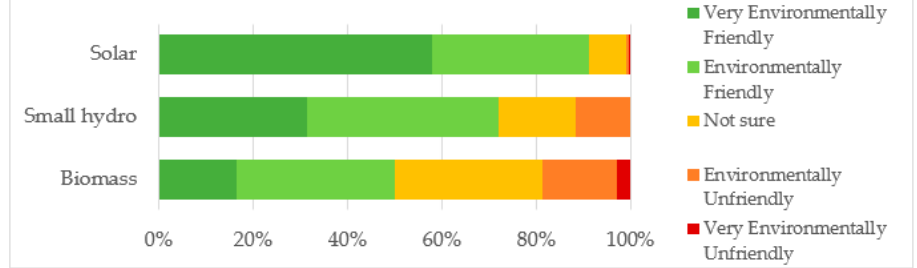
Figure 4. Opinions about the environmental friendliness of renewable energy (RE) sources.